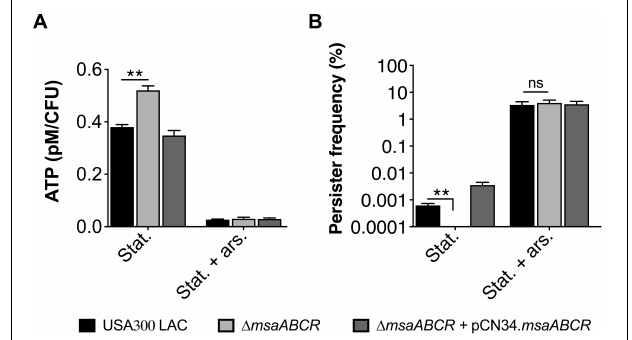
FIGURE 4 | Measurement of ATP level and persister frequency in the presence of arsenate. (A) ATP concentrations were measured at stationary growth phase in the presence of 1 mM arsenate. The data represent the average of three ATP concentrations per CFU of each individual sample measured with two biological replicates. (B) Persister frequency (log 10 survival fraction) was measured in stationary-phase culture against gentamicin (20 µ g/ml), with and without prior exposure to arsenate. The data represent the results from three independent experiments. Error bars represent the SEM. Statistical significance was determined using ANOVA followed by Tukey’s multiple comparison tests. **, P <